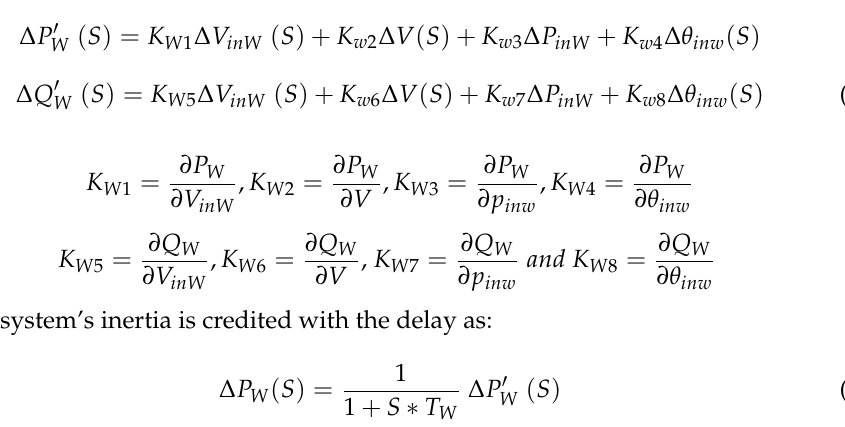
Figure 3. The block diagram of WECS.